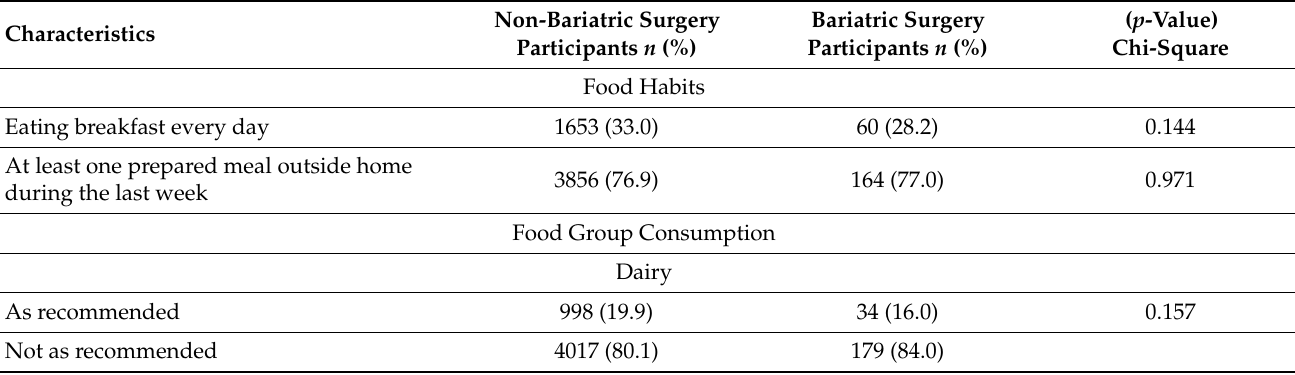
Table 4. Food consumption comparison between general population and bariatric surgery participants.